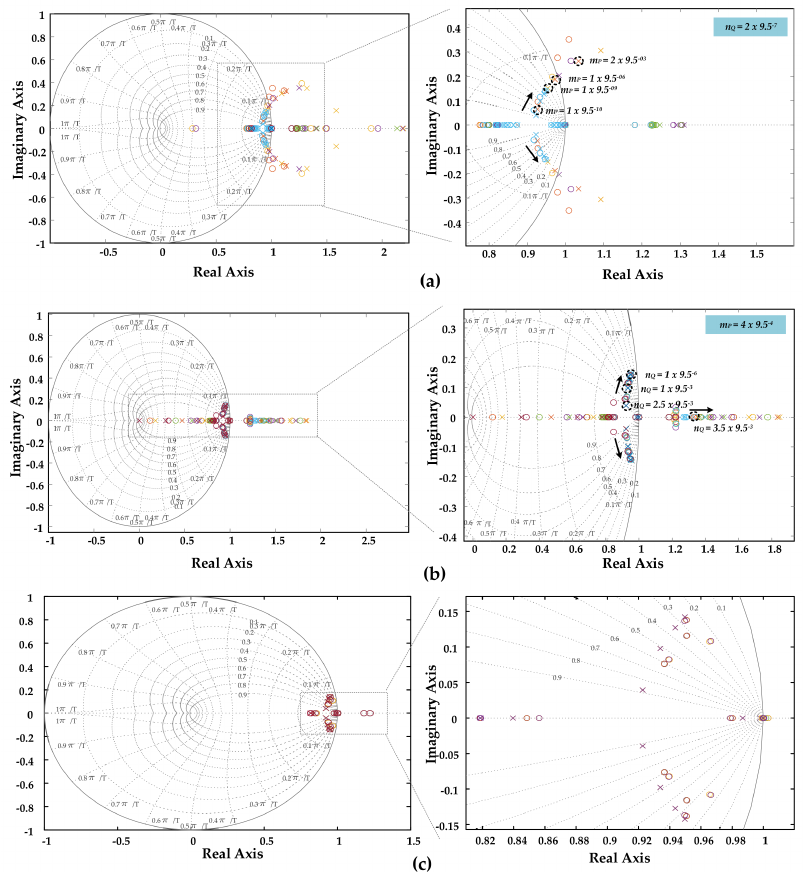
Figure 4. Poles zero plots: ( a ) effect of the m Pi variation; ( b ) effect of the n Qi variation; ( c ) effect of the time delay t d on system